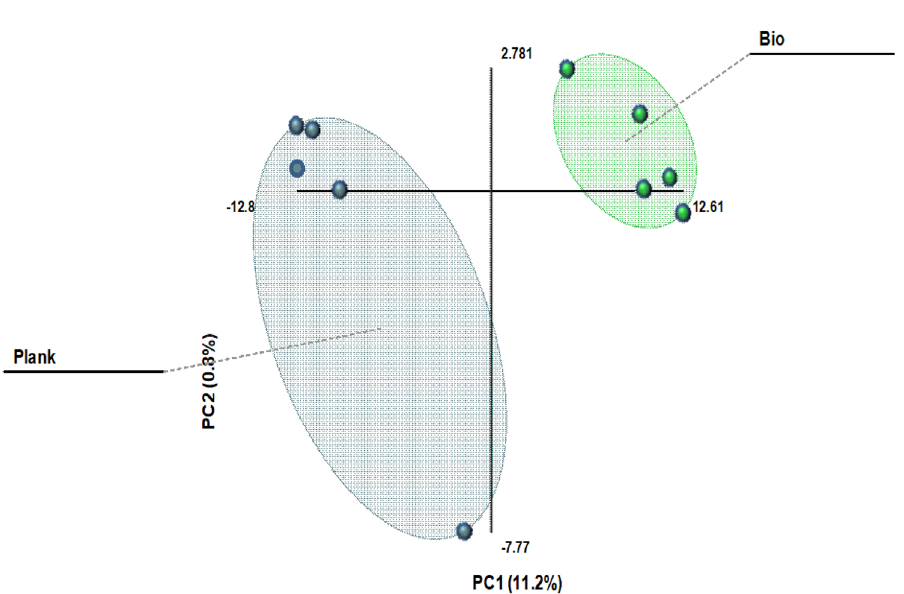
Figure 8. PCA scores plot for diffusion data for Mycoplasma pneumoniae. PC1 describes the majority of the variation